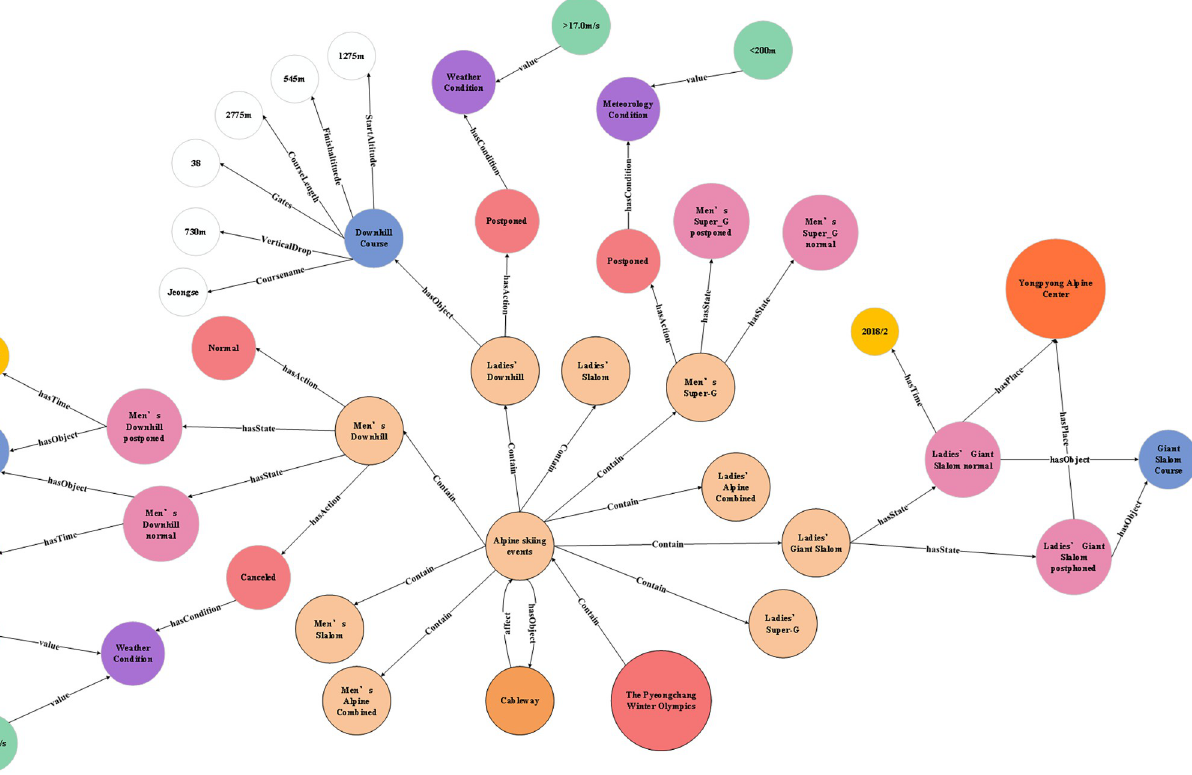
Fig 6. Part of the alpine skiing event KG (Neo4j visualization